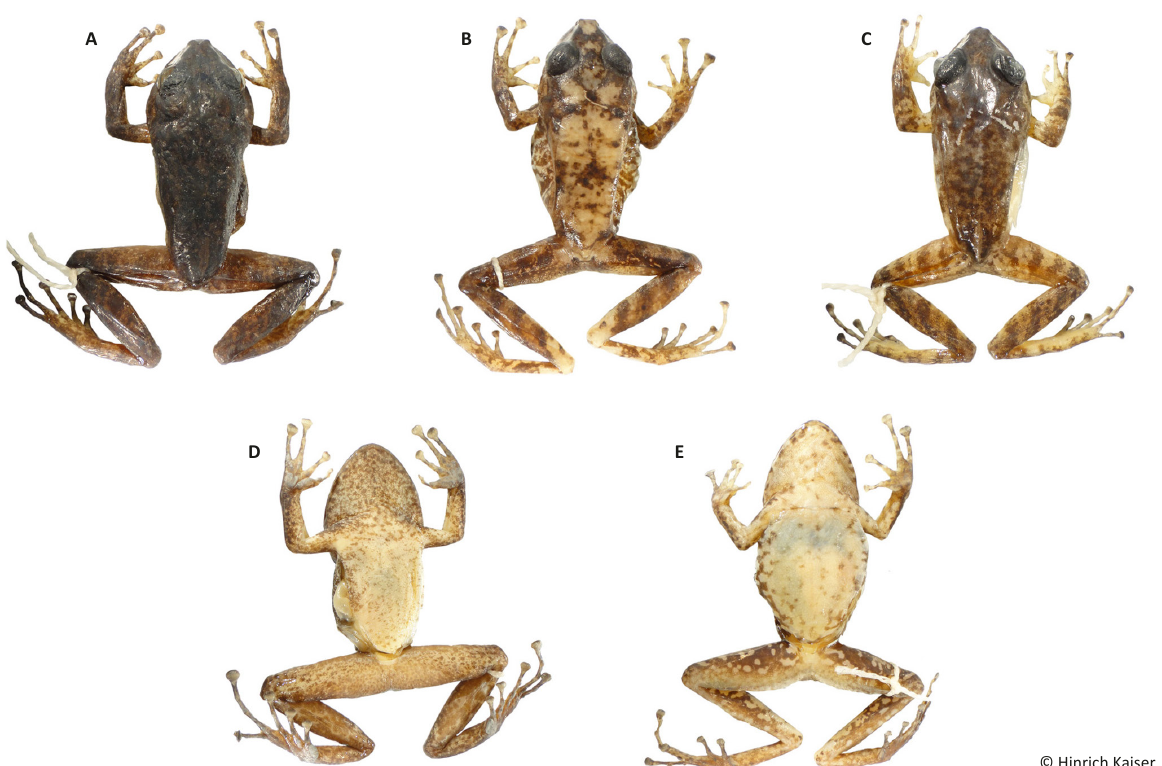
Image 9. Dorsal and ventral pattern variation of Pristimantis hoogmoedi sp. nov., illustrating the plain phenotype (A; CVULA 7433, holotype, female, SVL = 51.0mm), the ‘extravagant’ phenotype (B; CVULA 7434, female, SVL = 41.6mm), and a specimen with an intermediate phenotype (C; CVULA 7437, male, SVL = 32.2mm). The ventral coloration is relatively plain, with a varying degree of spotting. In some specimens, there is a greater density of brown melanophores on the chin, giving it a spotted look (D; CVULA 7433, holotype). In other specimens, the spotting is less dense and more generally distributed across the venter (E; CVULA